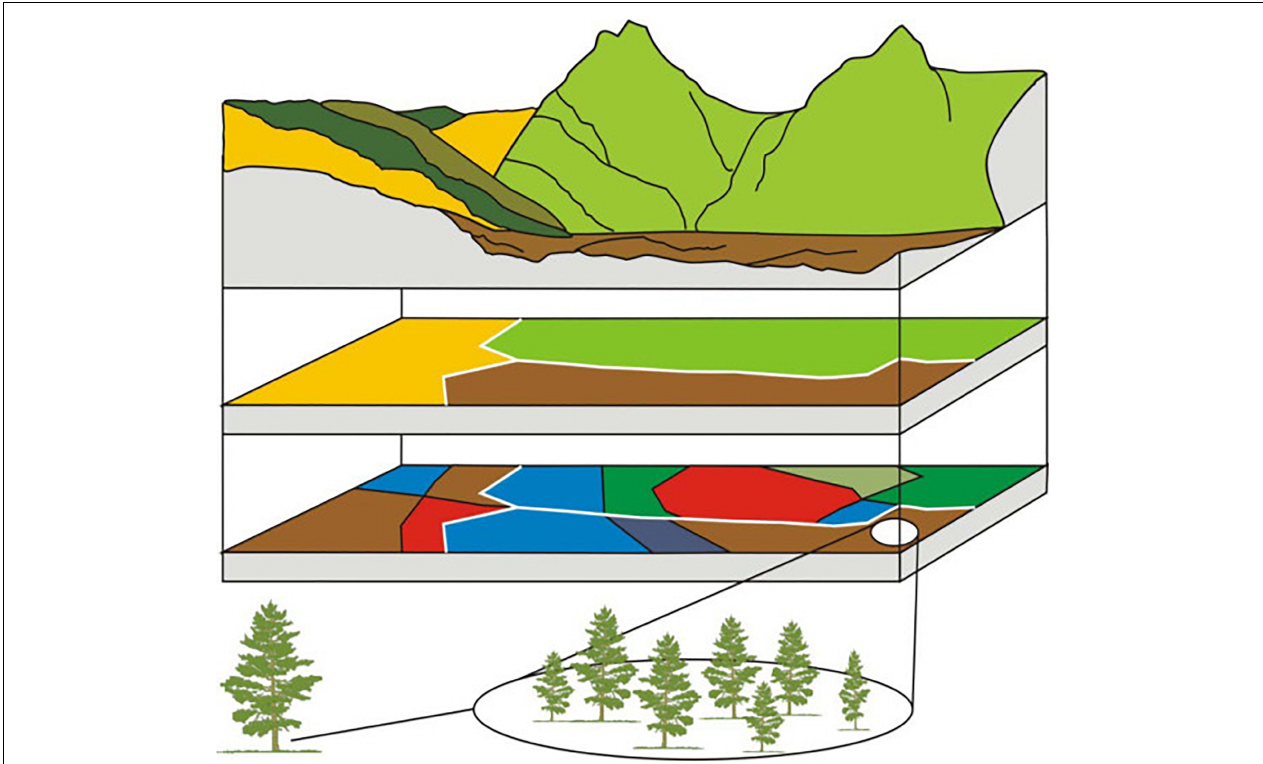
FIGURE 1 | Structure of nested tree, plot, stand, and site layers that make up the FireBGCv2 simulation landscape (Keane et al., 2011). Tree, plot, and stand inputs are developed from field sampling. Site and landscape inputs are developed from the LANDFIRE national vegetation model biophysical setting layer, digital elevation model, and existing vegetation layers (LANDFIRE, 2014). Site-level fire history and fuel data were drawn from a combination of previous data sets (Danzer et al., 1996; Miller et al., 2003) and new field-collected data.